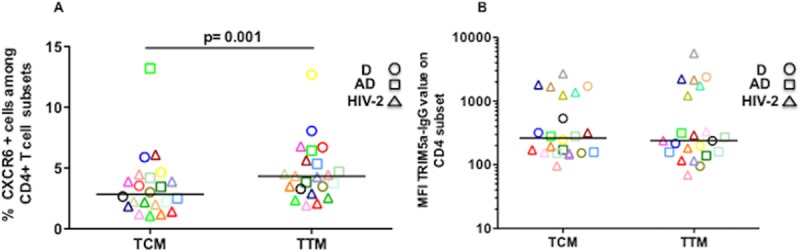
Flow-cytometry analysis of CXCR6 and TRIM5α proteic expression in TCM and TTM CD4+ T cells Flow cytometry analysis of central-memory (TCM; CD45RA-CCR7+CD27+) and in transitional memory (TTM; CD45RA-CCR7-CD27+) CD4+ T-cells subsets from 12 HIV-2 infected subjects (open triangle), 4 donors (D) (open dot) and 5 West-African donors (AD) (open squares) showing the A) Cell surface expression of CXCR6. B) Mean fluorescence intensity (MFI) of intra-cellular TRIM5α after subtracting the secondary immunoglobulin MFI. Each symbol represents a subject and the medians are shown.